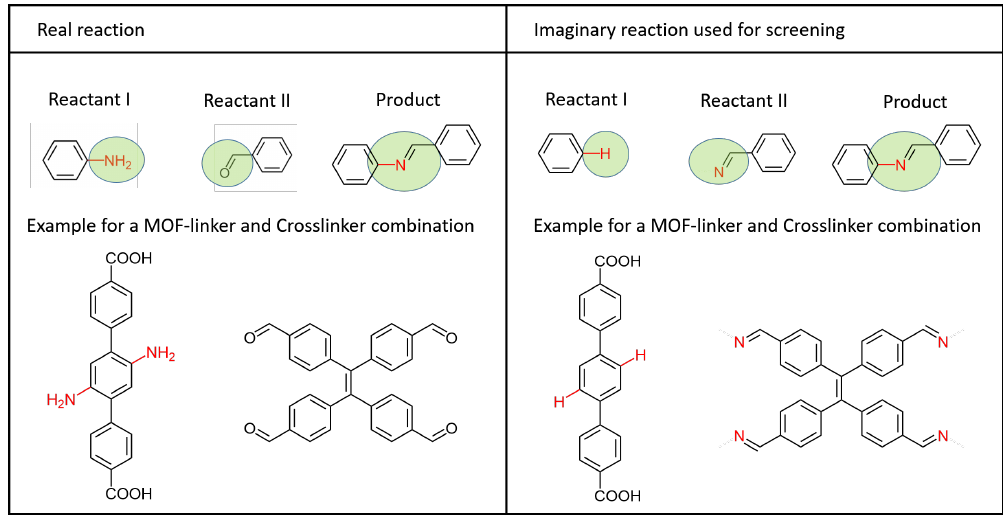
Figure 13. The laboratory conditions would be, as shown on the left, that the MOF is functionalized with an amine group. This amine group can then react with the oxygen of the cross-linker and form the MOF/cross-linker bond. However, the structures in the MOF database are stored in their unmodified form. To simplify our virtual screening, the cross-linker is assumed to carry the product of the reaction, and the MOF remains in its unmodified state, as shown on the right side. The atom in whose place the amine group was bound is now the atom that is replaced by the binding atom of the